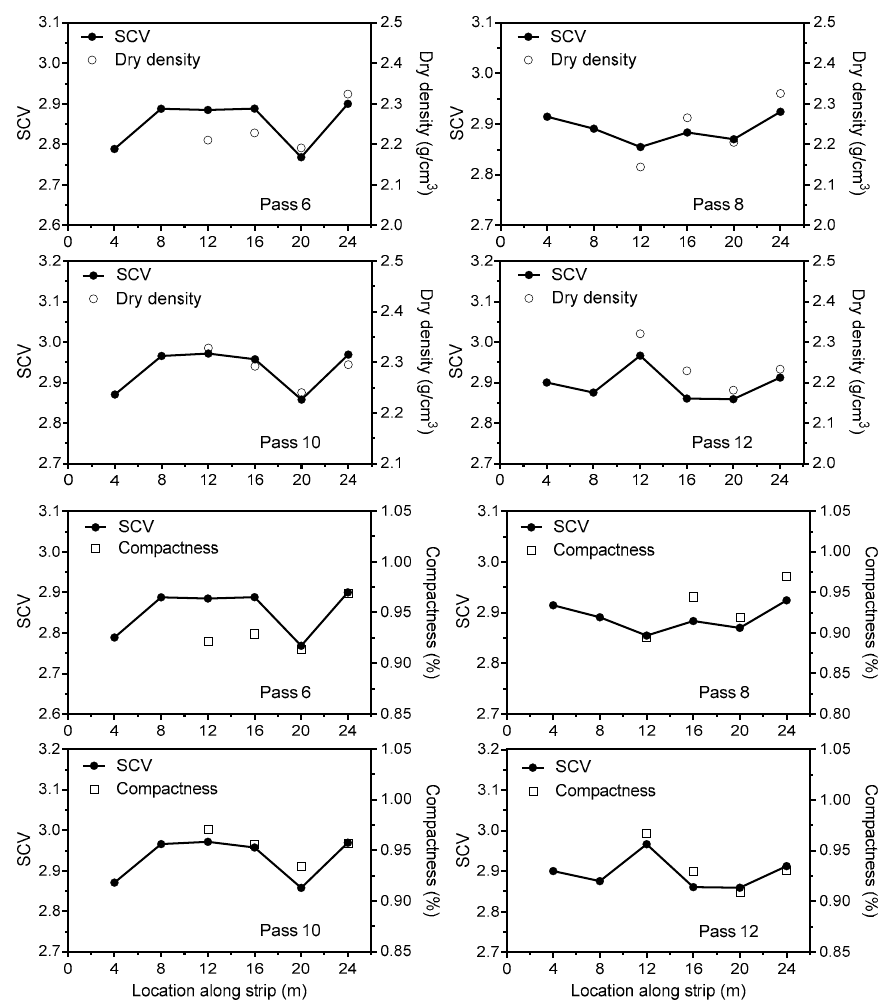
Figure 16. SCV, dry density, SCV, and compactness at each block along Strip 1.